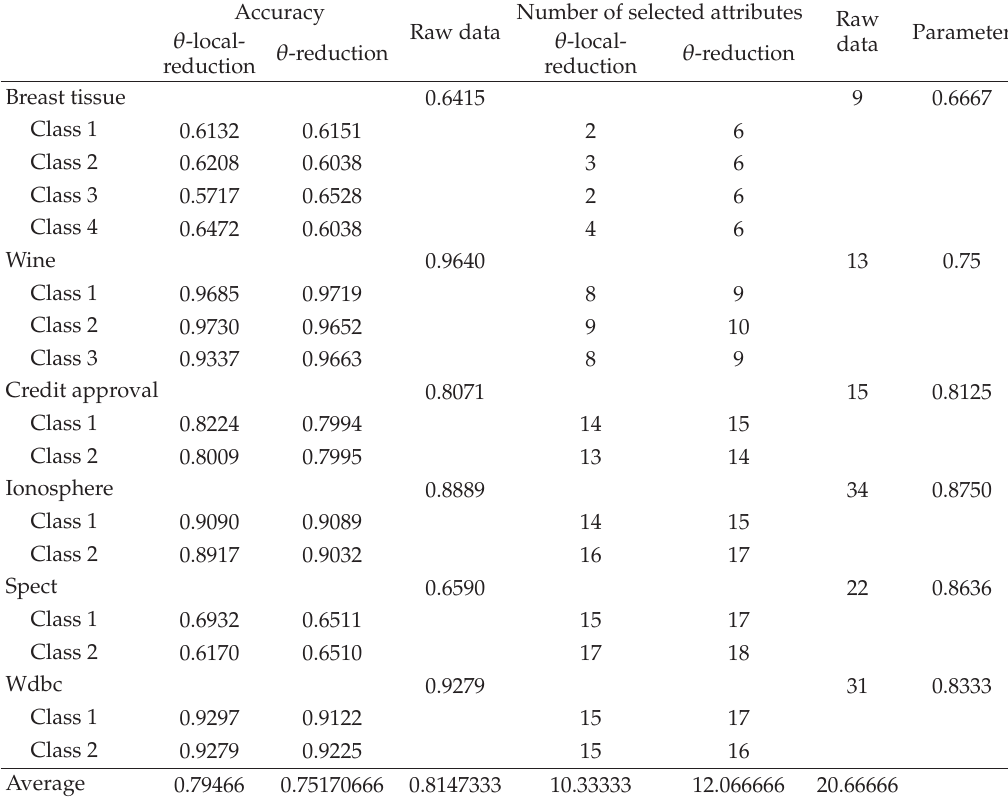
Table 5: Comparison between θ -local reduction and θ